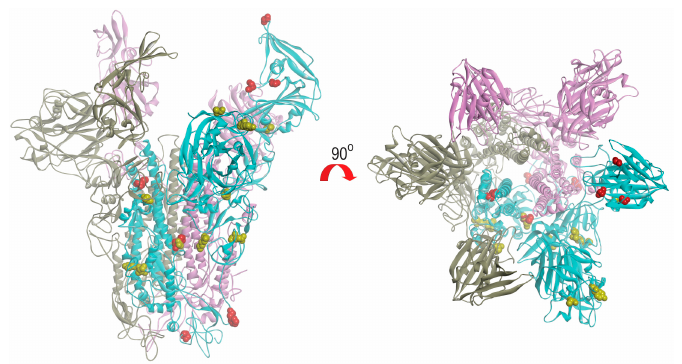
Figure 6. Structural view of amino acid substitutions in S protein of different clades of MERS-CoV. The mutated amino acids in clade A and B are highlighted in yellow and red colour, respectively. The figures were produced using Discovery Studio visualizer (Accelrys).